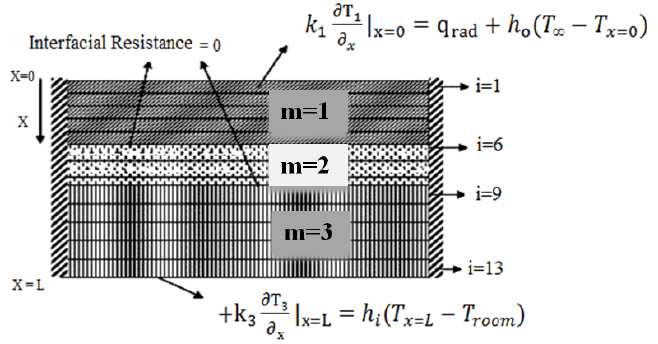
Figure 2. Finite volume grid for the analysis.